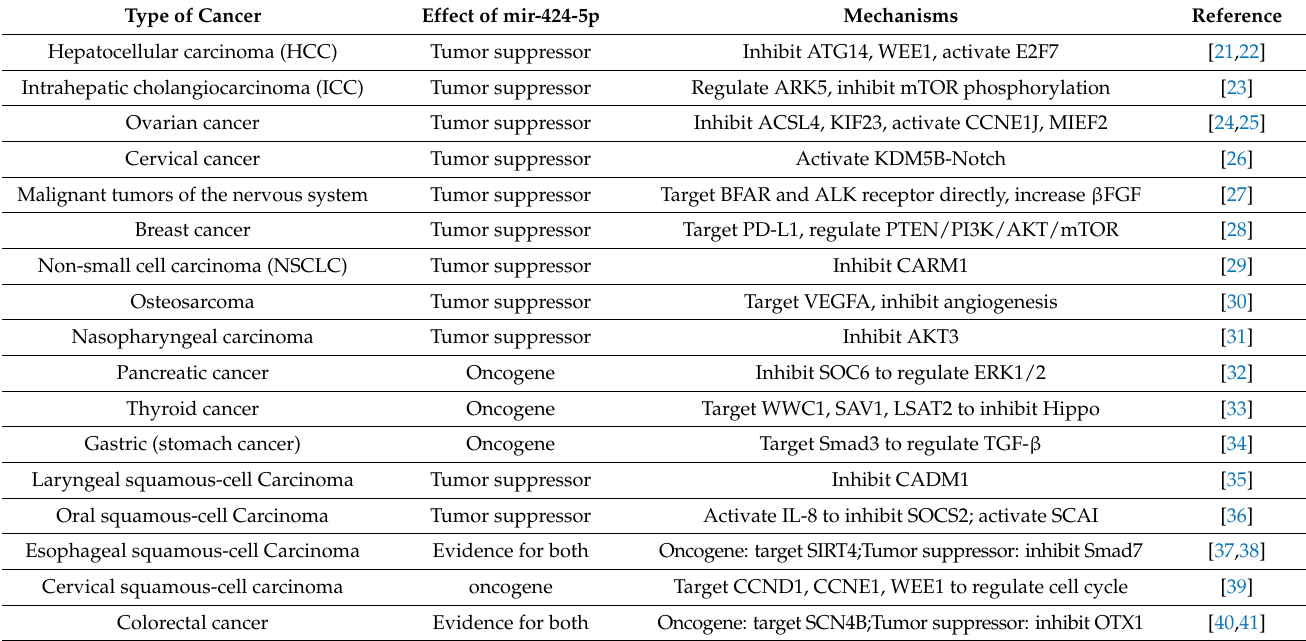
Table 1. Role of miR-424-5p in various